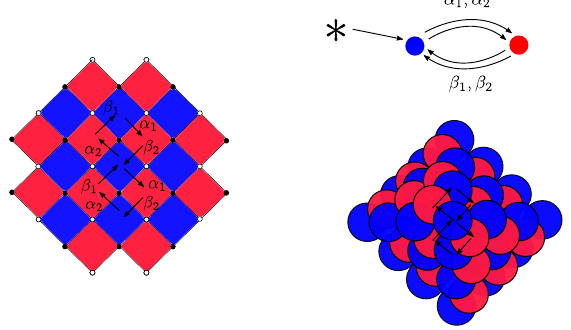
Figure 10. Enhanced quiver diagram, universal covering of it and the three-dimensional crystal of the conifold